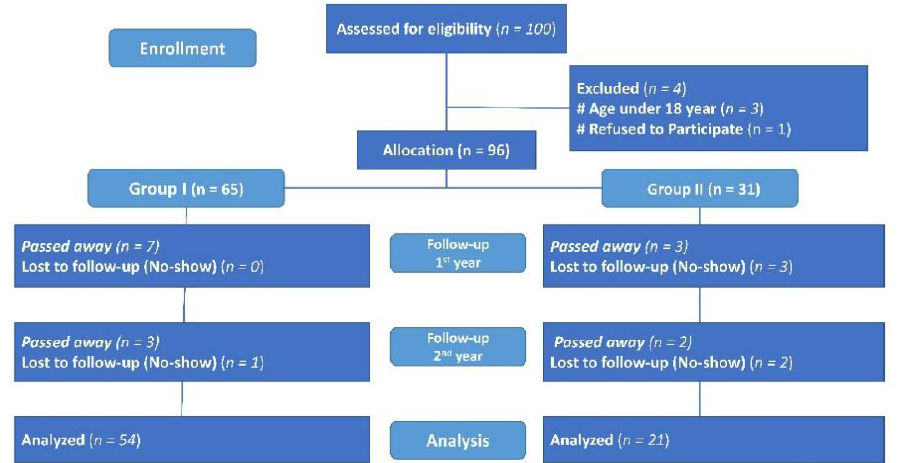
Figure 2. CONSORT diagram showing participants’ flow throughout the study.